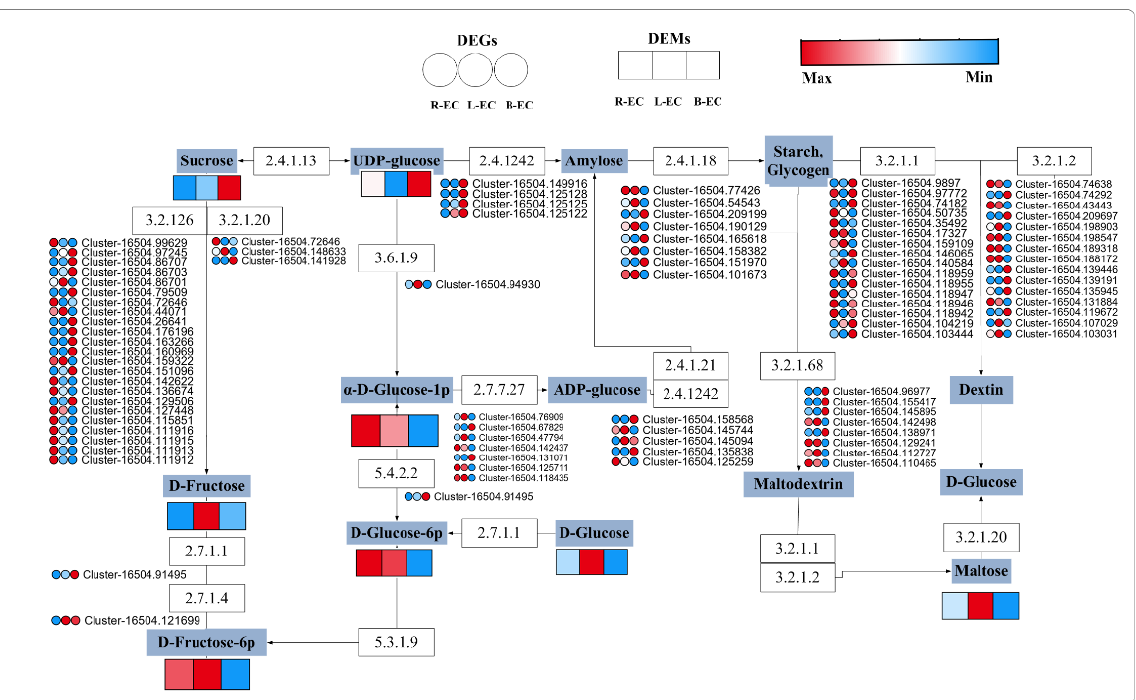
Figure 9. Analysis of DEGs and DEMs from starch and glucose metabolism pathways among Korean pine R-EC, L-EC, and B-EC cell lines. 3.1.1.26: beta-fructofuranosidase, 3.2.1.20: maltase-glucoamylase, 2.4.1.13: sucrose synthase, 3.6.1.9: nucleotide diphosphatase, 2.4.1242: granule-bound starch synthase, 2.4.1.18: 1,4-alpha-glucan branching enzyme, 3.2.1.1: alpha-amylase, 3.2.1.2: beta-amylase. 2.4.1.21: starch synthase, 3.2.1.68: isoamylase, 5.4.2.2: phosphoglucomutase, 2.7.7.27: glu- cose-1-phosphate adenylyltransferase, 2.7.1.1: hexokinase, 2.7.1.4: fructokinase, 5.3.1.9: glucose-6- phosphate isomerase.